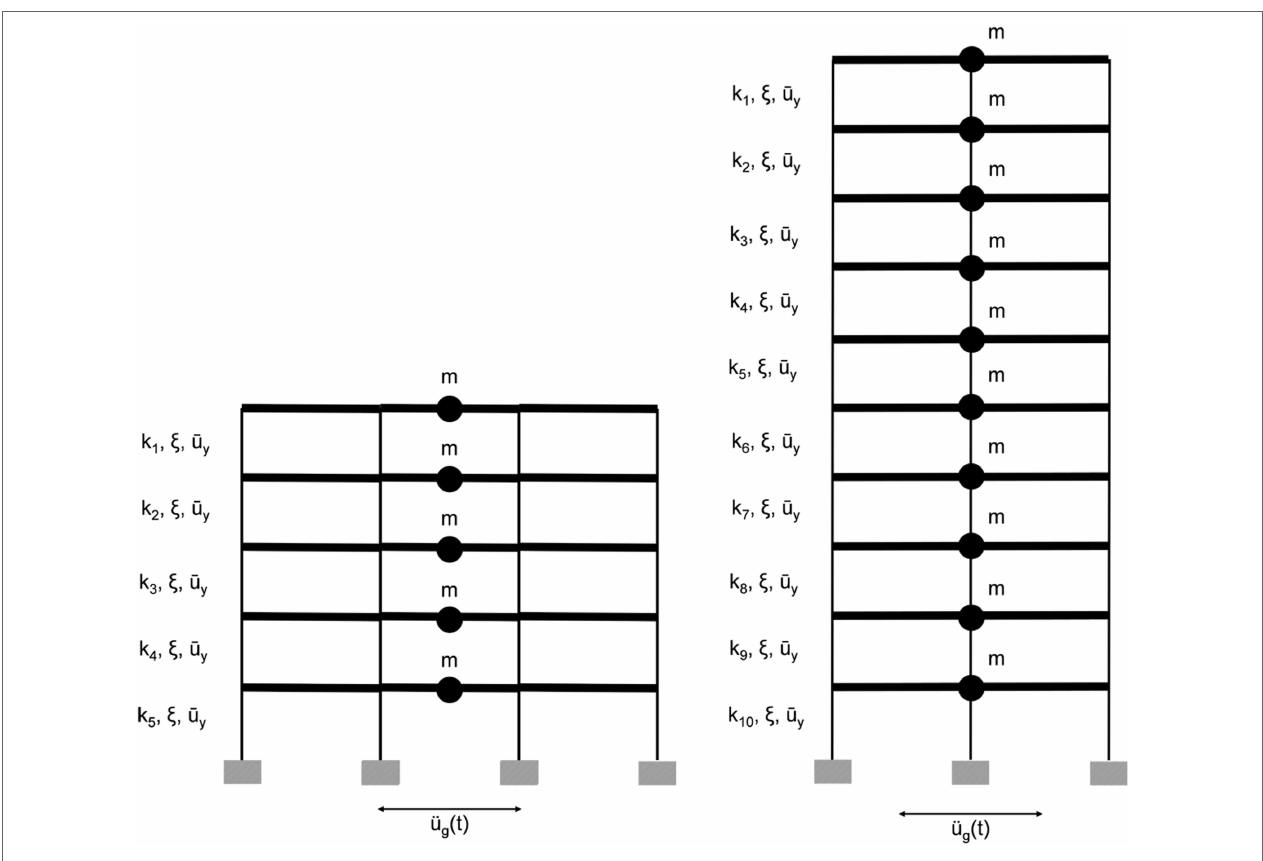
FIGURE 1 | Planar shear building models analyzed in this study with 5 and 10 storeys.